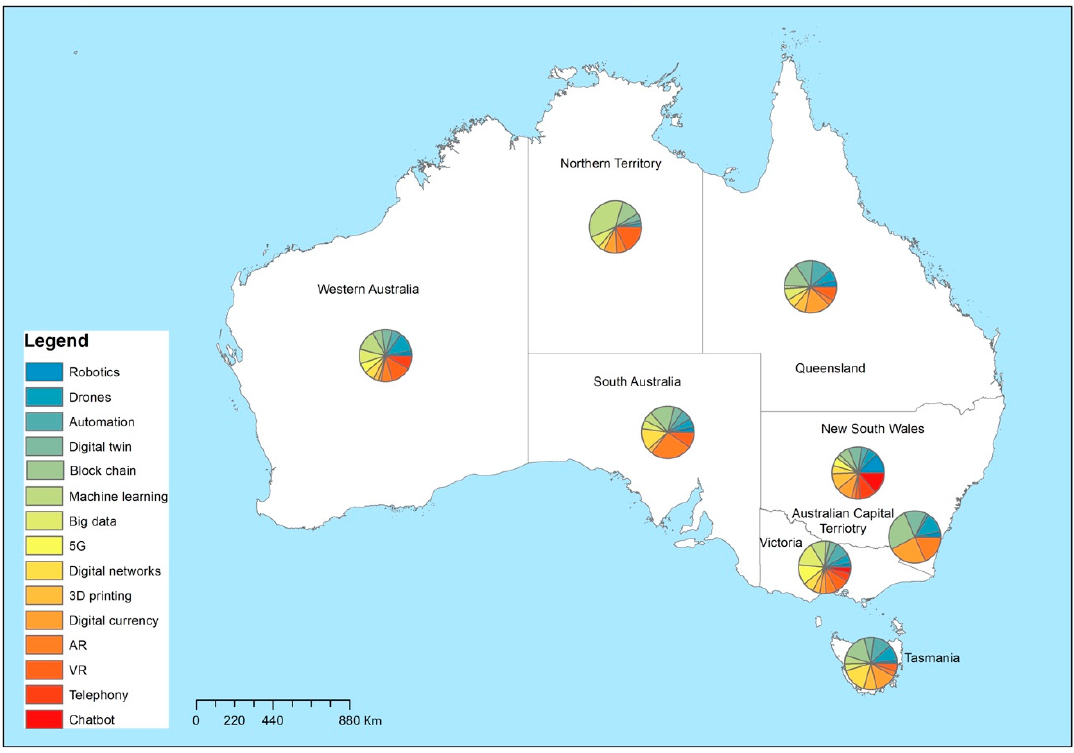
Figure 3. Distribution of tweets by artificial intelligence (AI)-related technologies per state/territory.